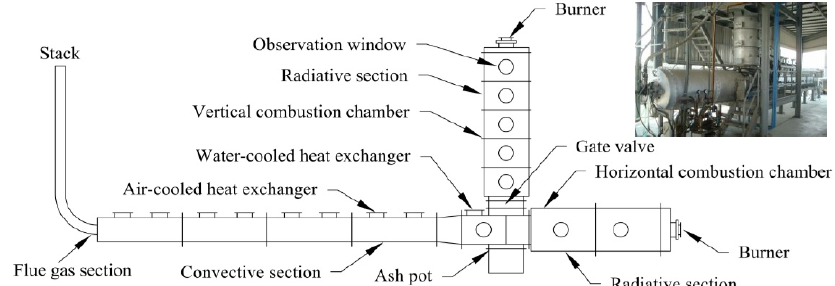
Figure 1. Schematic diagram of the 300 ‐ kW th multi ‐ fuel test furnace.